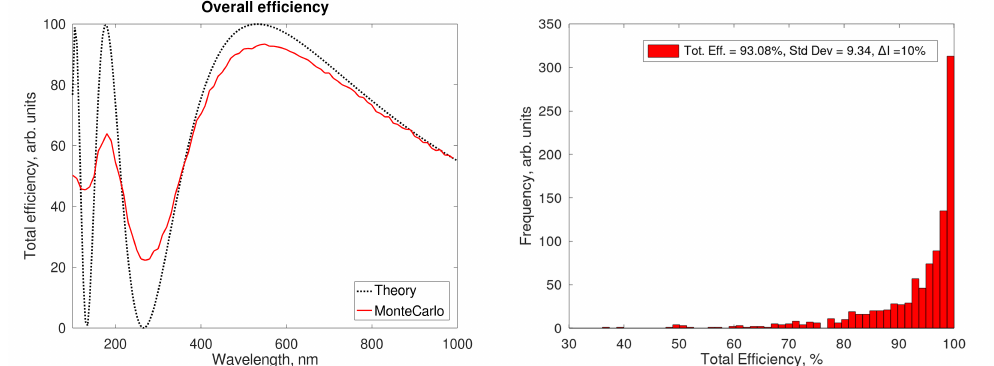
Figure 11. ( Left panel) Transfer function of an ideal Kerr gate without (black dashed) and with (red solid) random fluctuations. We considered 1 mm of TiO 2 as active medium, d = 1 µ m, T = 100 ps (E = 23.58 nJ; see Table 2) and the maximum fluctuations reported in Table 3, column “Errors”; ( Right panel) total efficiency distribution obtained by a Monte Carlo